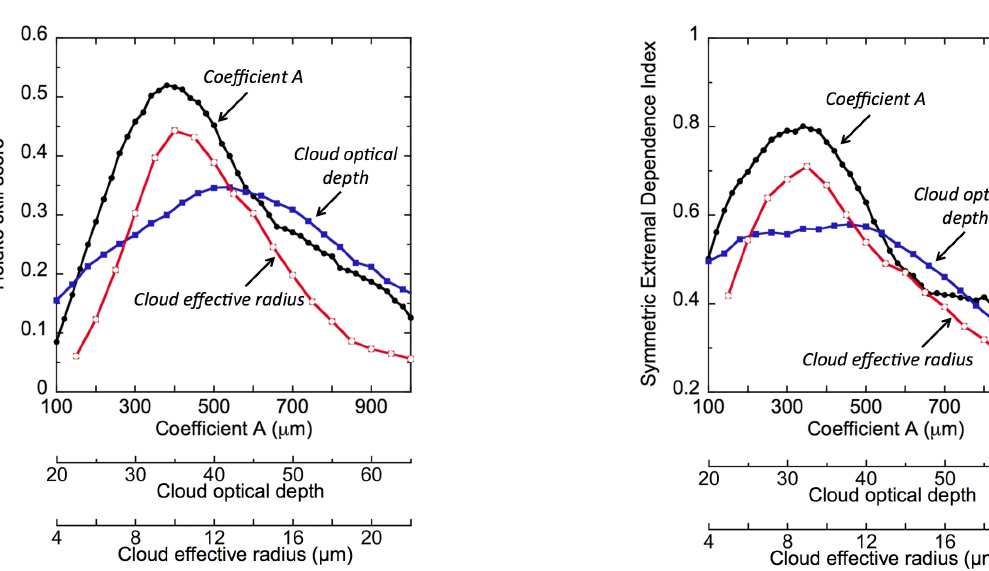
Figure 12. Same as Fig. 11, but using the symmetric extremal de- pendence index to optimise thresholds for drizzle